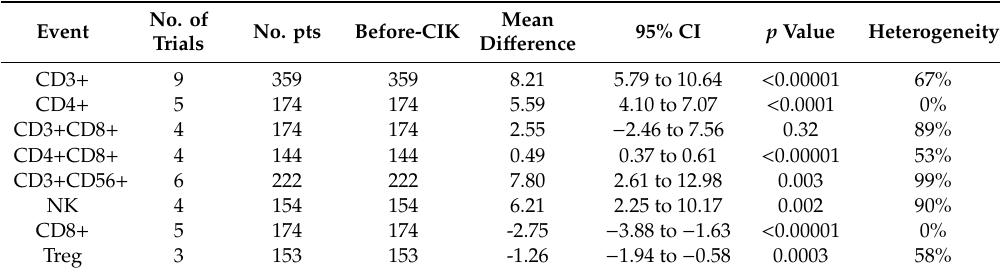
Table 2. Lymphocytes subsets in peripheral blood before CIK treatment and after CIK therapy (modified from [57]).